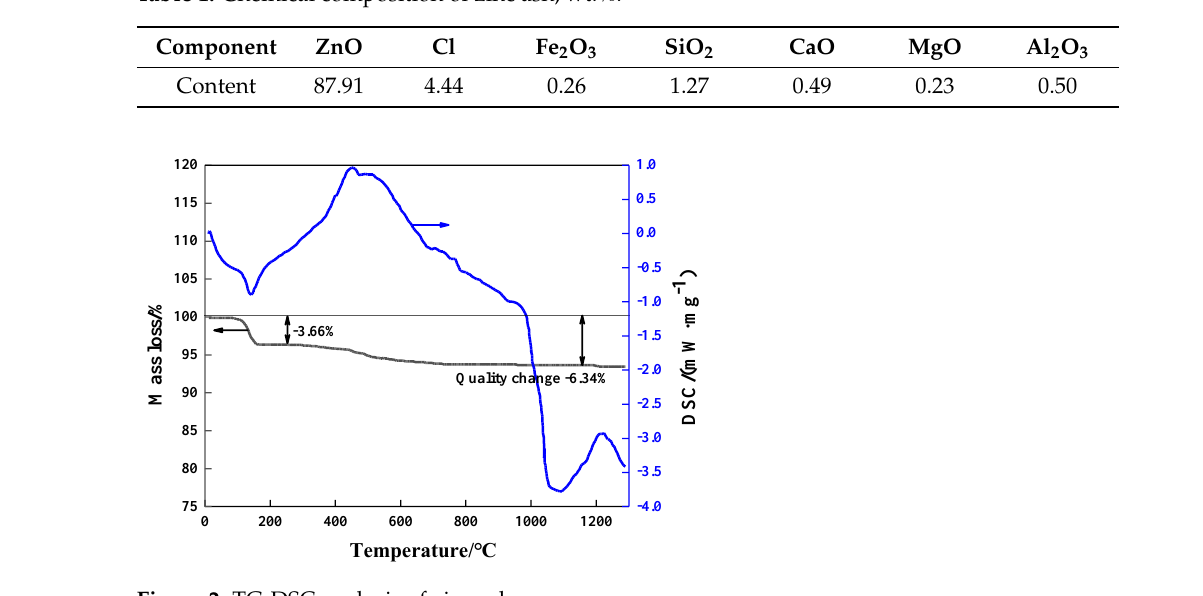
Table 1. Chemical composition of zinc ash, wt.%.